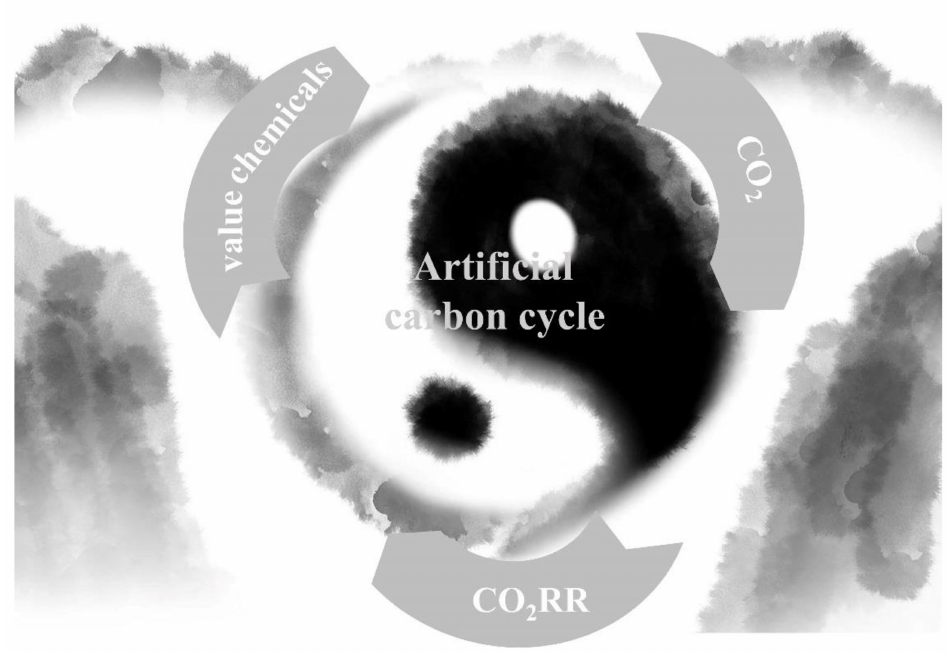
Figure 1. Schematic illustration of CO 2 –RR toward artificial carbon cycle. Table 1. Standard electrochemical potentials for CO 2